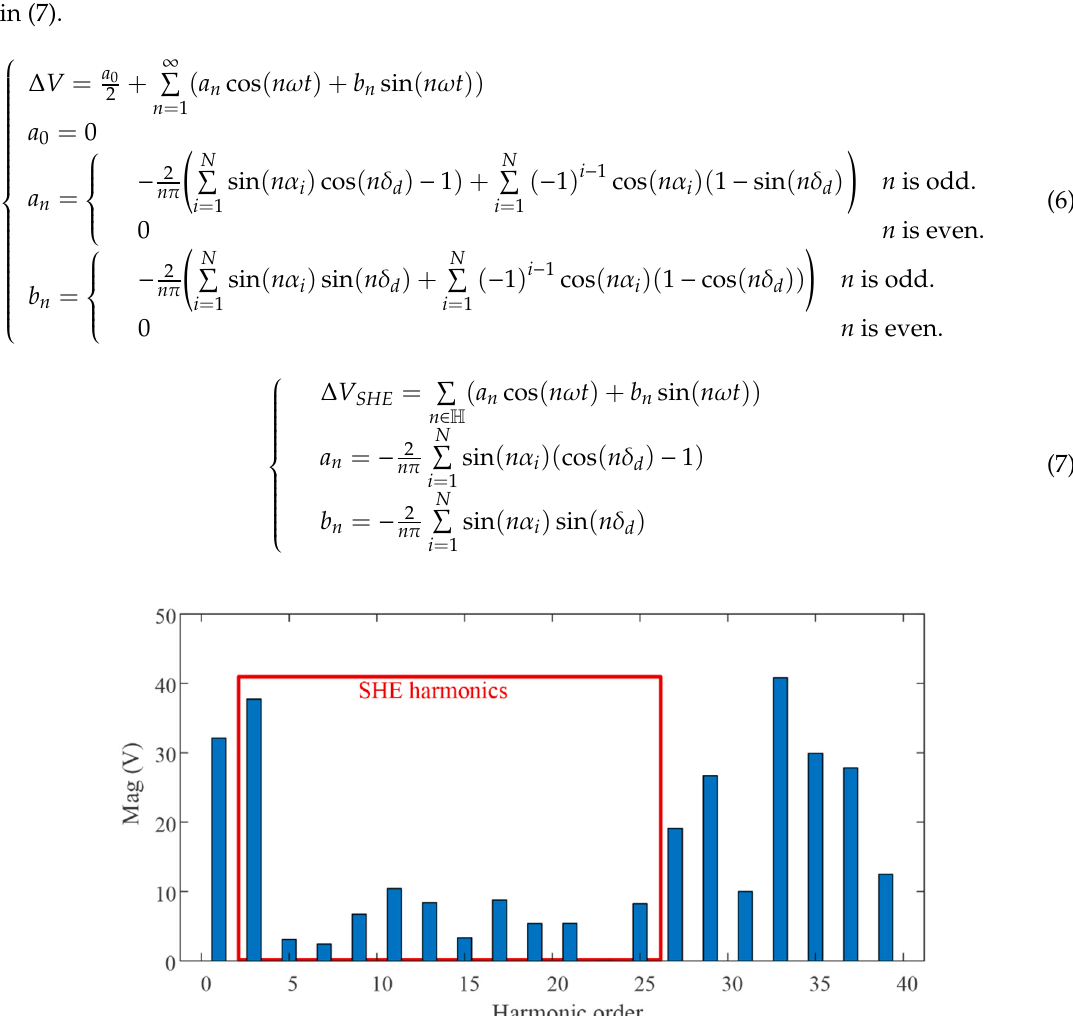
Figure 8. Harmonic distribution of ∆ V , with θ = 30 ◦ , T d = 10 µ s, M = 0.95, and N = 9 .